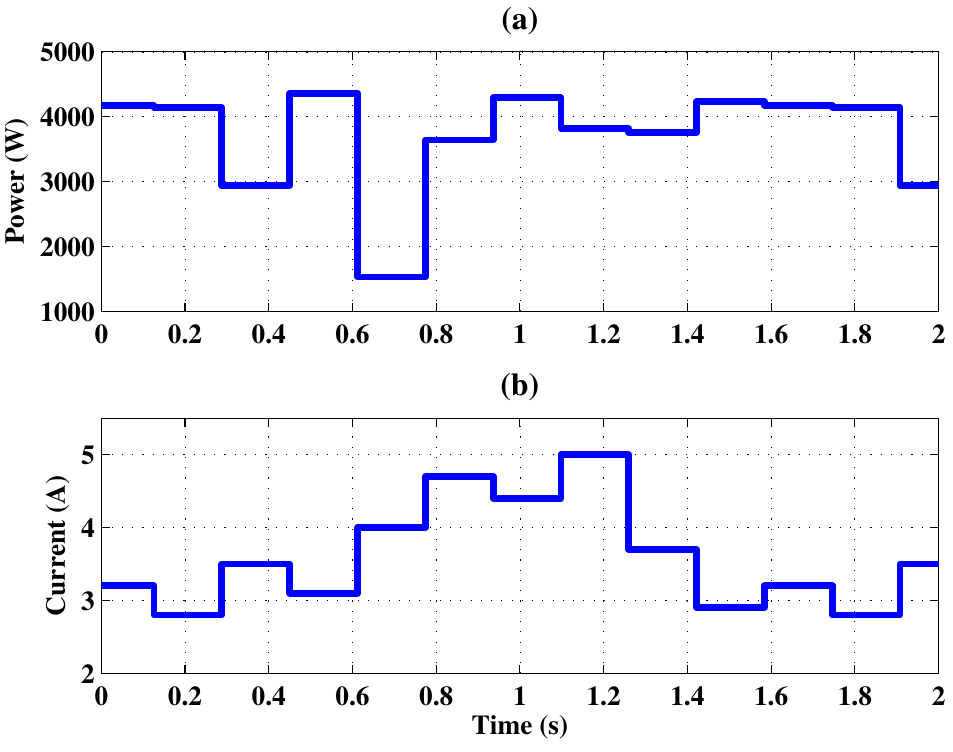
Figure 14. ( a ) Solar power available and ( b ) load profiles for HIL